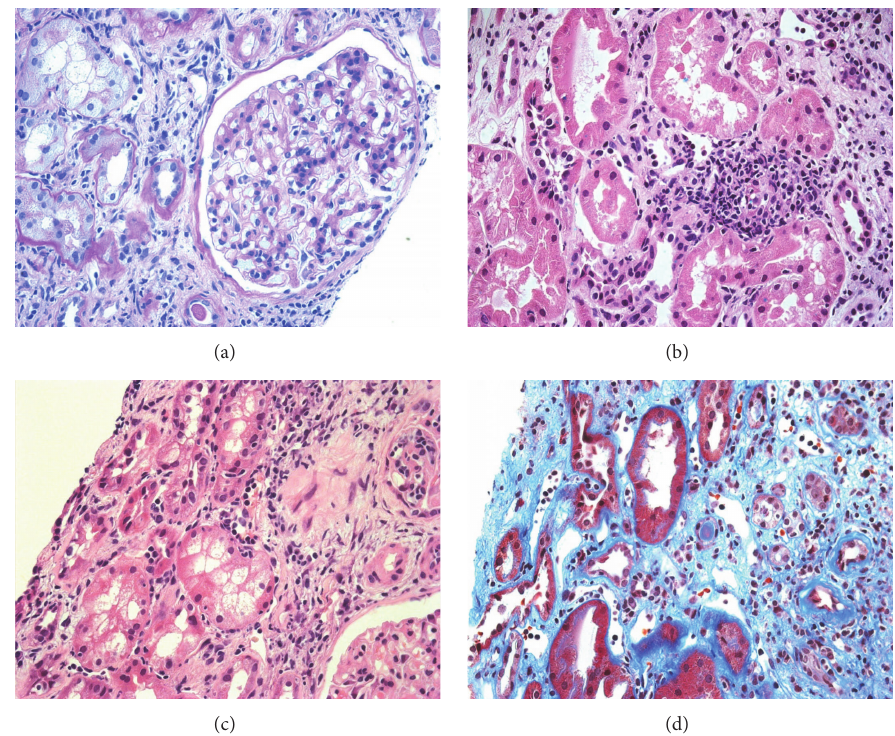
Figure 3: Light microscopic findings in a second biopsy at 3 months after the first antirejection therapy. (a) Transplant glomerulitis, mild (PAS, × 100), (b, c) mild infiltration of inflammatory cells including plasma cells; and mildly developed tubulitis was noted (HE, × 400 (b), × 200 (c)). (d) Peritubular capillaritis was moderately developed (Masson’s Trichrome, × 400).